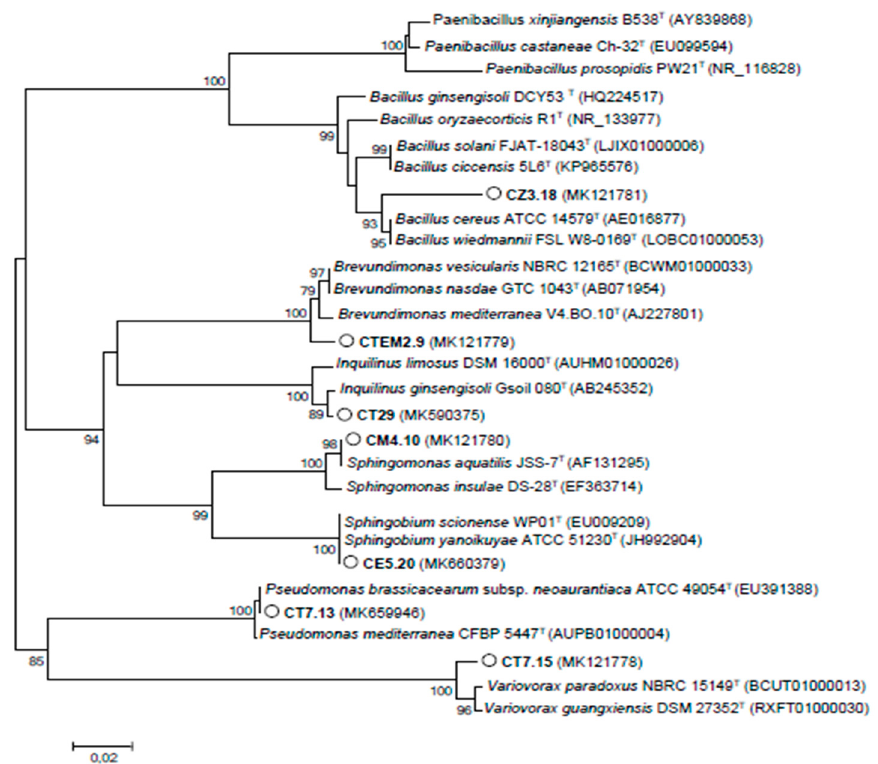
Figure 4. Neighbour-joining phylogenetic tree based on the 16S rRNA gene of endophytic strains isolated from nodules of Calicotome villosa . Bootstrap confidence levels were derived from 1000 replications, and those greater than 75% are indicated at the internodes. Scale bar = 0.1 nucleotide divergence.